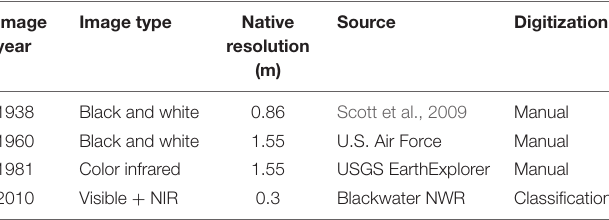
TABLE 1 | Aerial photography summary, native resolutions were resampled before analysis to 1.55 m as described in text. Image year